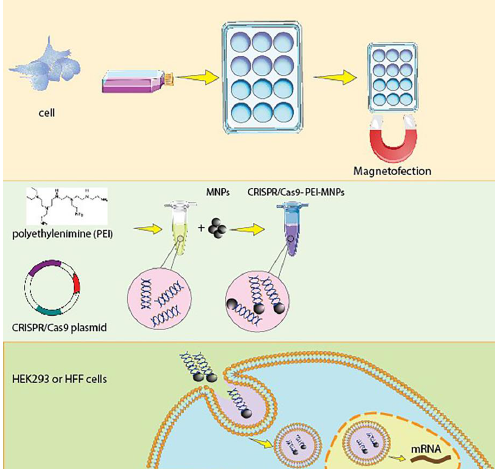
Figure 1. Schematic illustration of the synthesis of the CRISPR/Cas9-PEI-MNP complex. This system is constructed using the co-precipitation method, coated with PEI and further fused with a CRISPR/Cas9 plasmid to form a complex. The CRISPR/Cas9-PEI-MNP complex is transfected into HEK-293 and HFF cells via magnetofection. The CRISPR/Cas9-PEI-MNP complexes are internalized by the cells through the endocytosis pathway due to the cationic